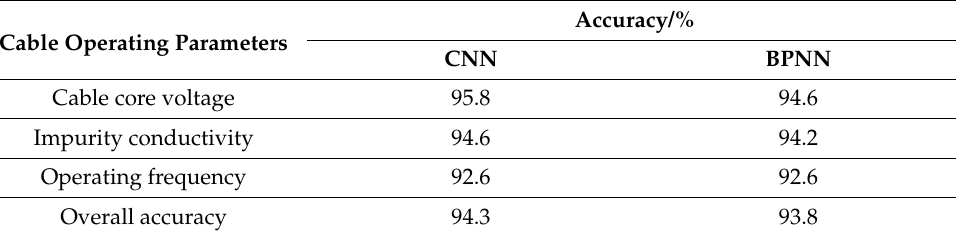
Table 4. Comparison of the computational accuracy of CNN and